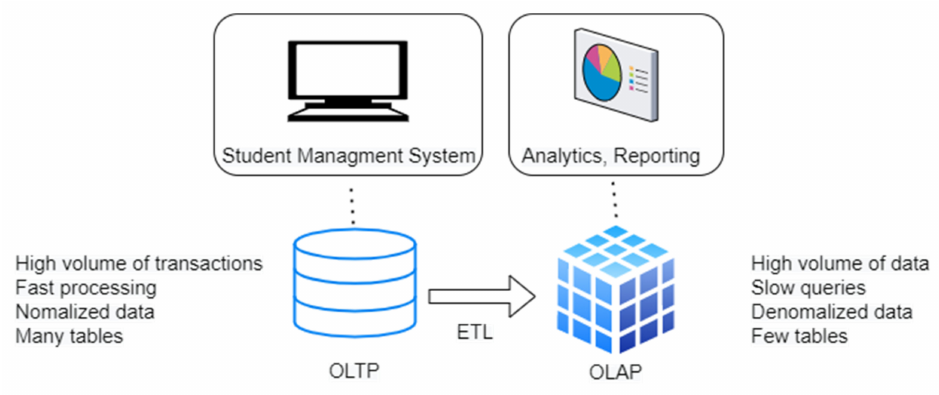
Figure 5. OLTP vs.